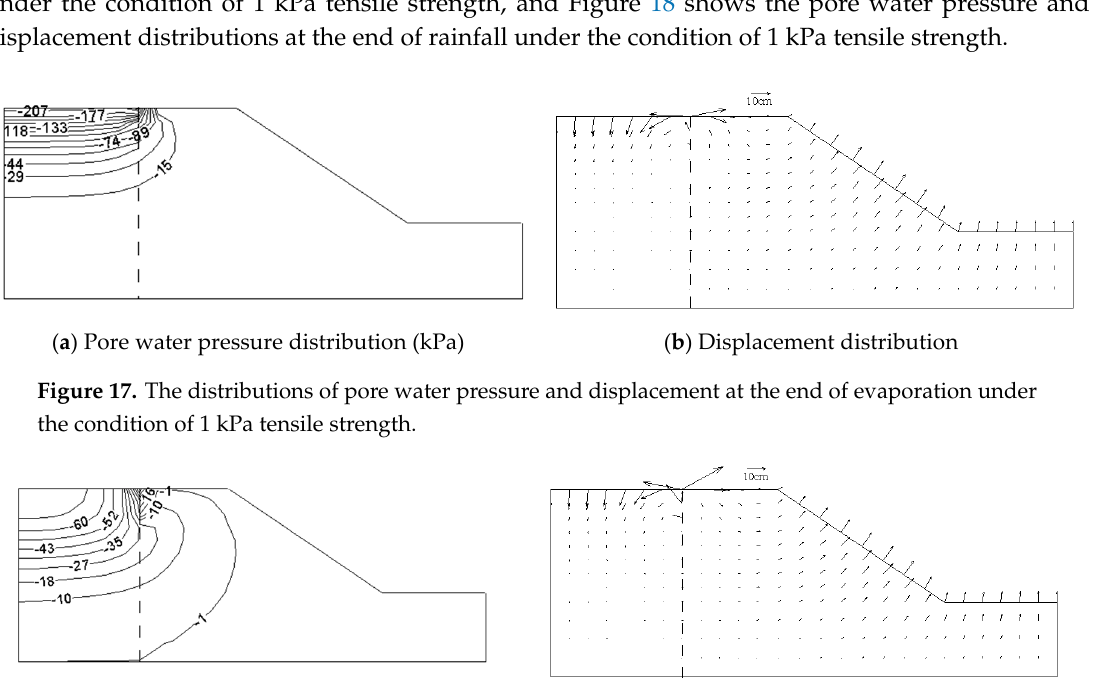
Figure 16. Crack-width–time curve with different infiltration rates during the rainfall period.